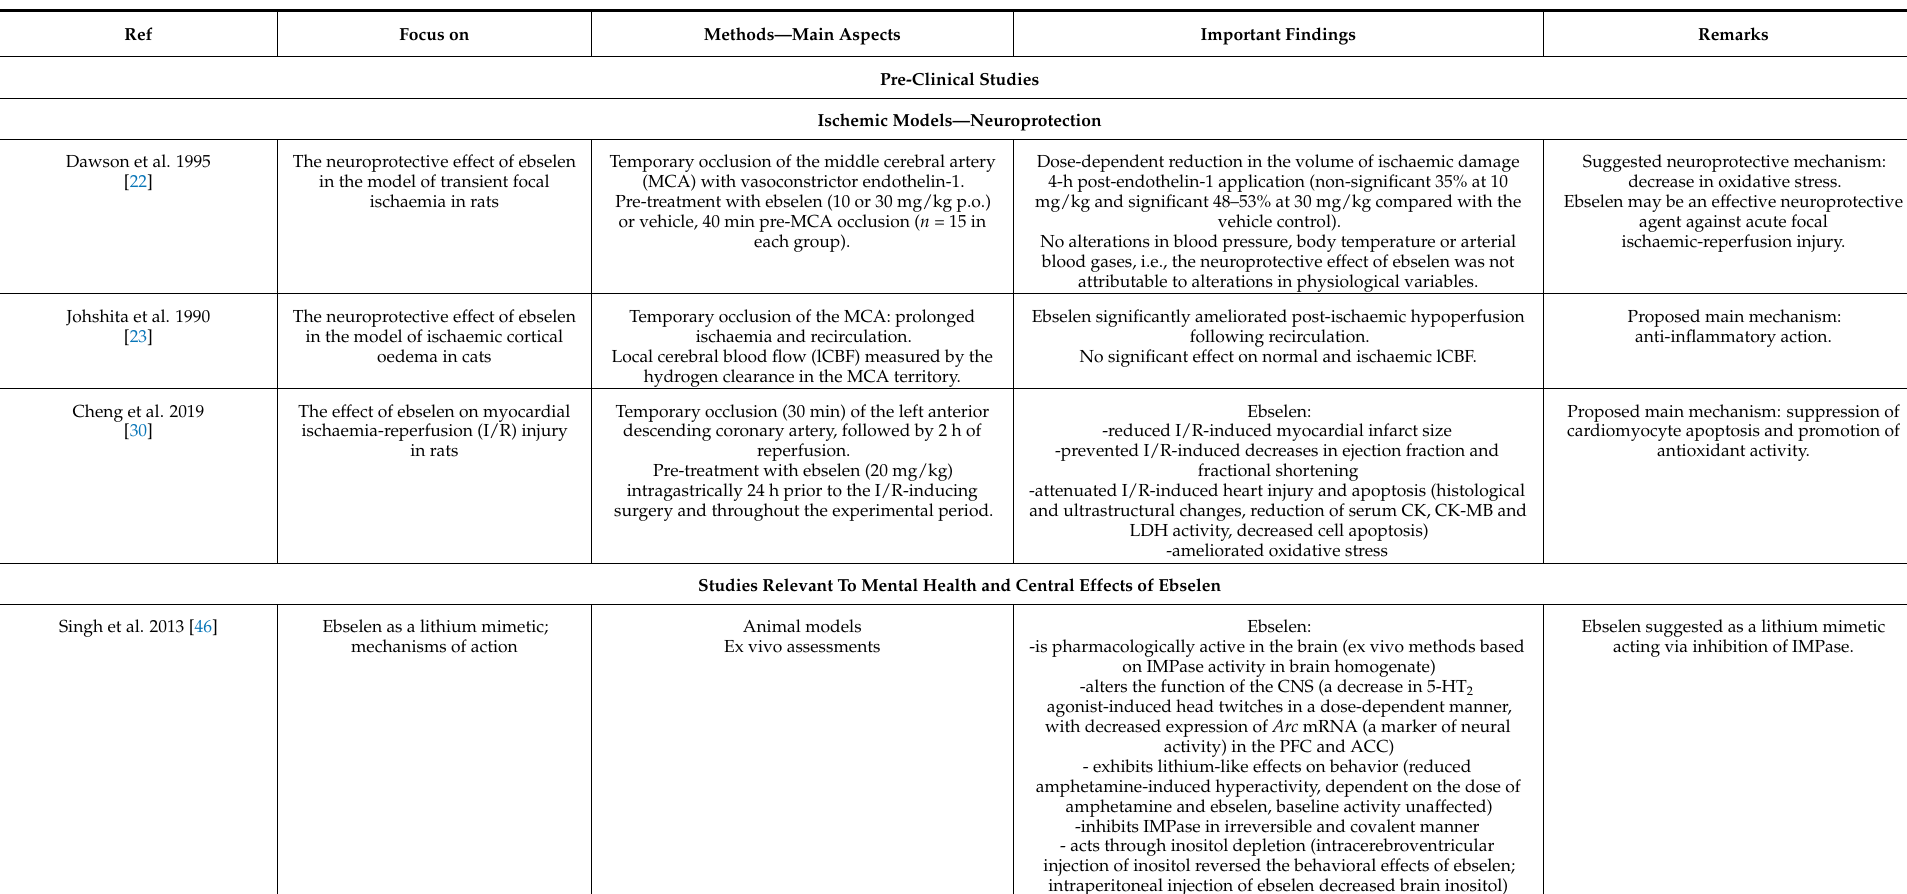
Table 1. A summary of studies discussed in the text. This table aims to provide more information on particular studies, but please note that this is not an exhaustive list of the studies conducted in the